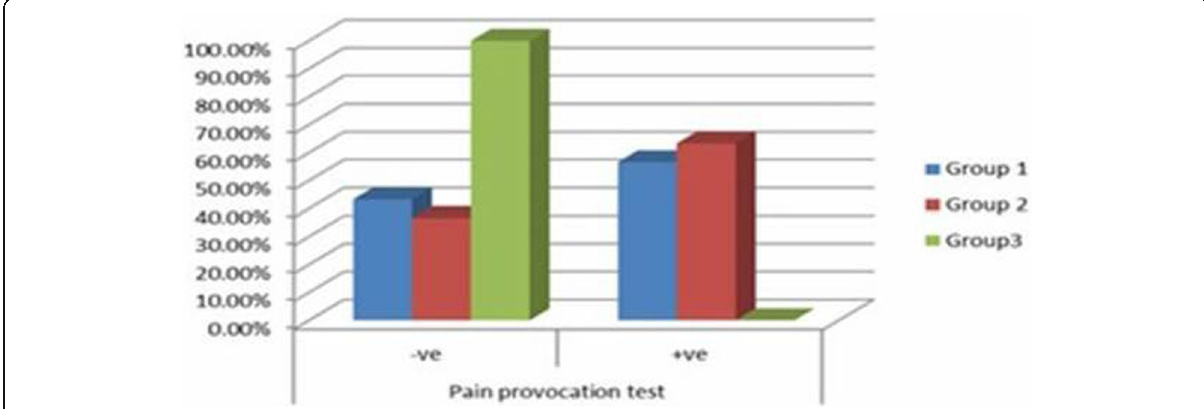
Fig. 4 Our clinical study revealed a significant statically differences of clinical signs regarding pain provocation test of infrapatellar nerve entrapment/injury in the affected side by comparing both first and second groups with the third group while the first and second groups were